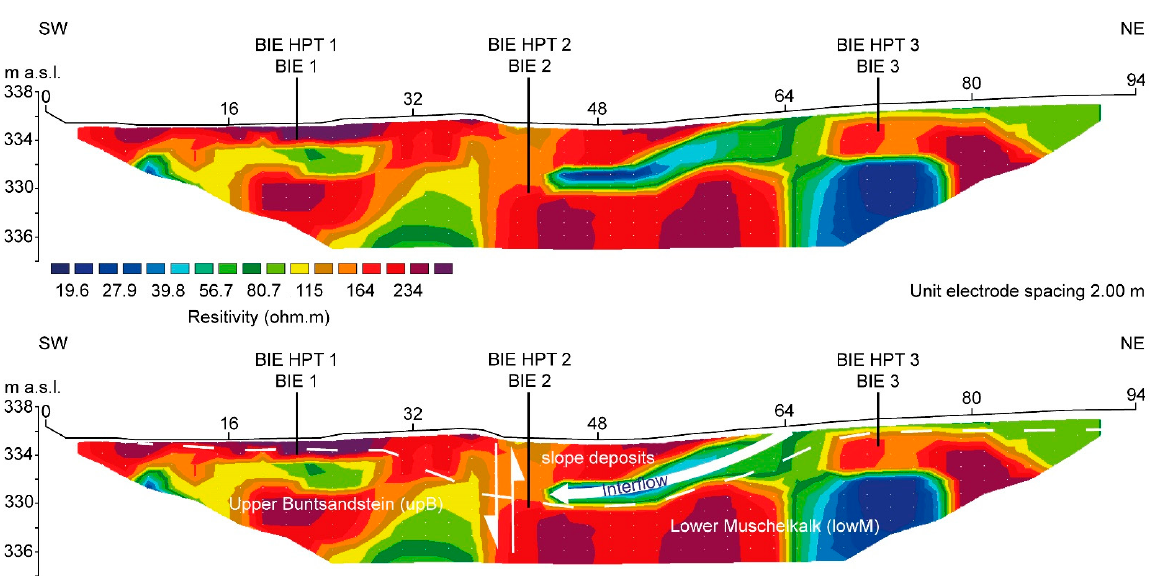
Figure 5. Upper: depth section of ERT transect BIE ERT 1 (iteration 6, absolute error 1.4%) and position of DP HPT logs and sediment cores retrieved from right above the scarped ridge (cp. Figure 1). Lower: depth section with interpretation according to field observation and geological data (see discussion in Section 5).